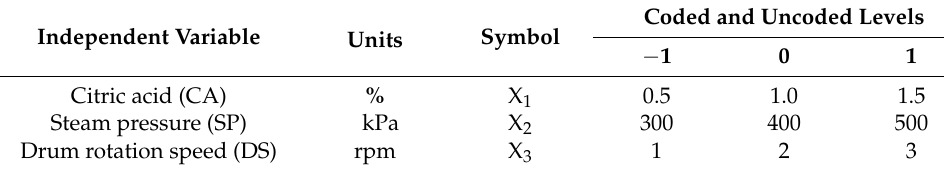
Table 1. Coded and uncoded values of the independent